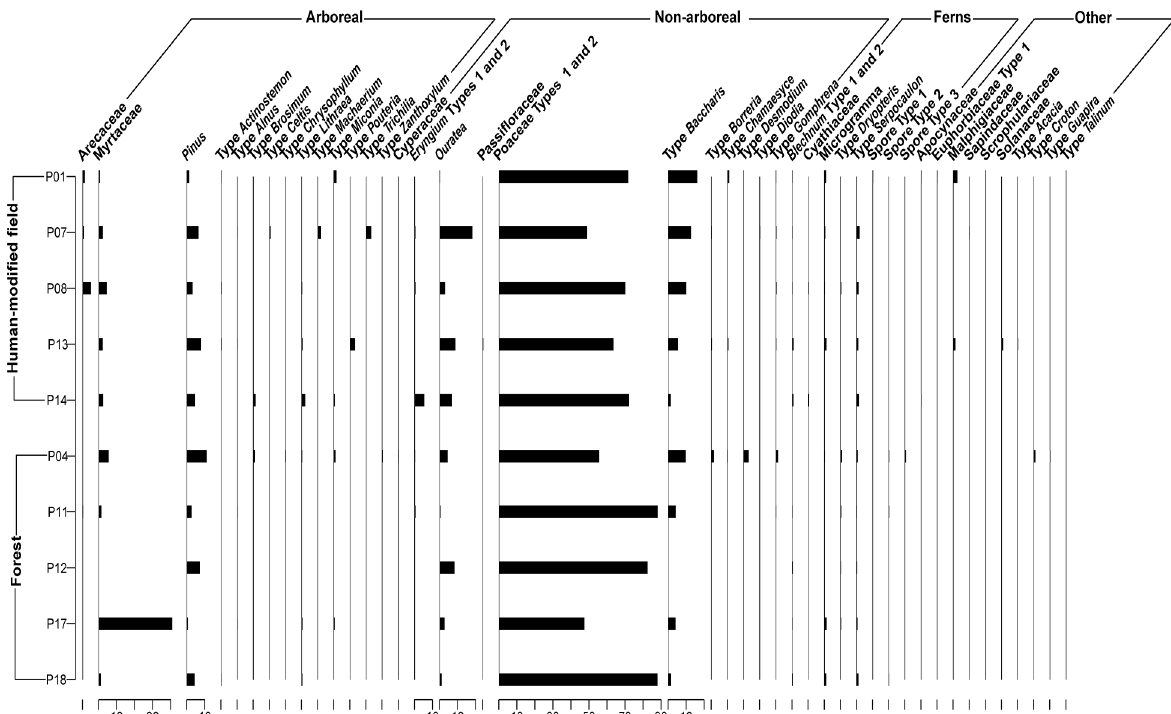
Figure 5. Pollen percentage spectra from surface samples from Itapuã State